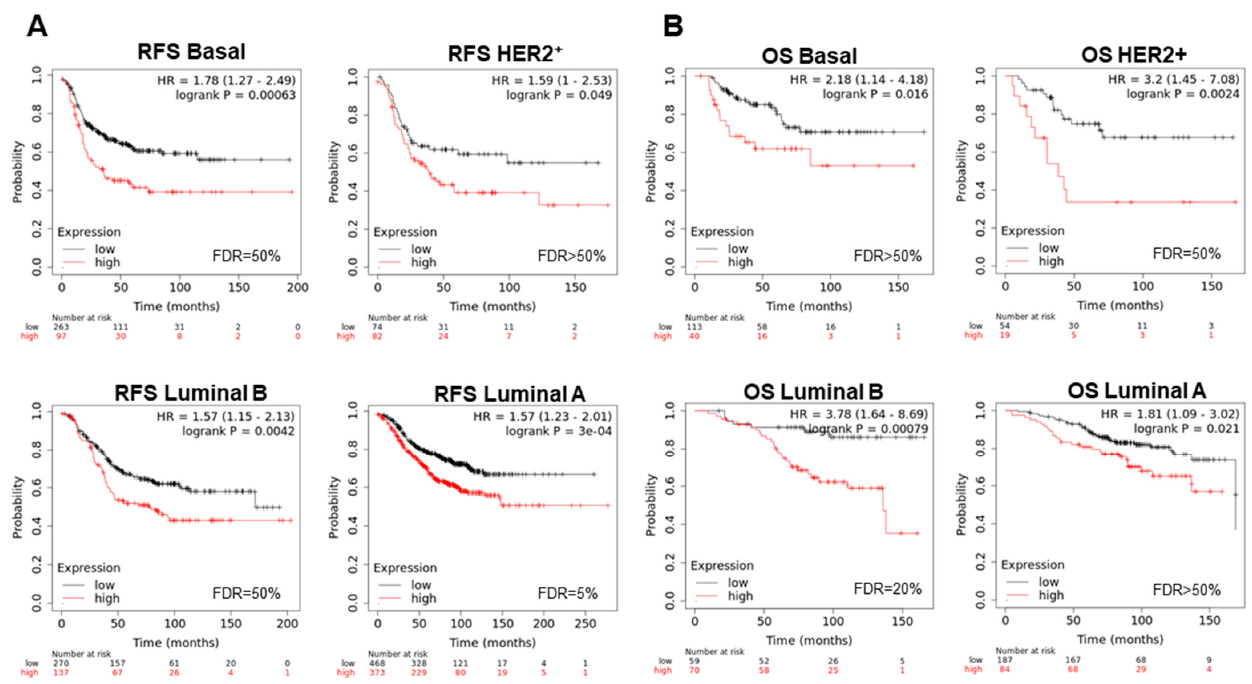
Figure 5. Association between expression of shared genes and a worse survival across intrinsic subtypes of breast cancer. ( A ) Survival analysis for 5 genes that are commonly altered in all breast cancer subtypes ( YWHAZ, UBE2T, RFWD2, PRKDC, and NBN ) with RFS ( B ) and OS across different subtypes .